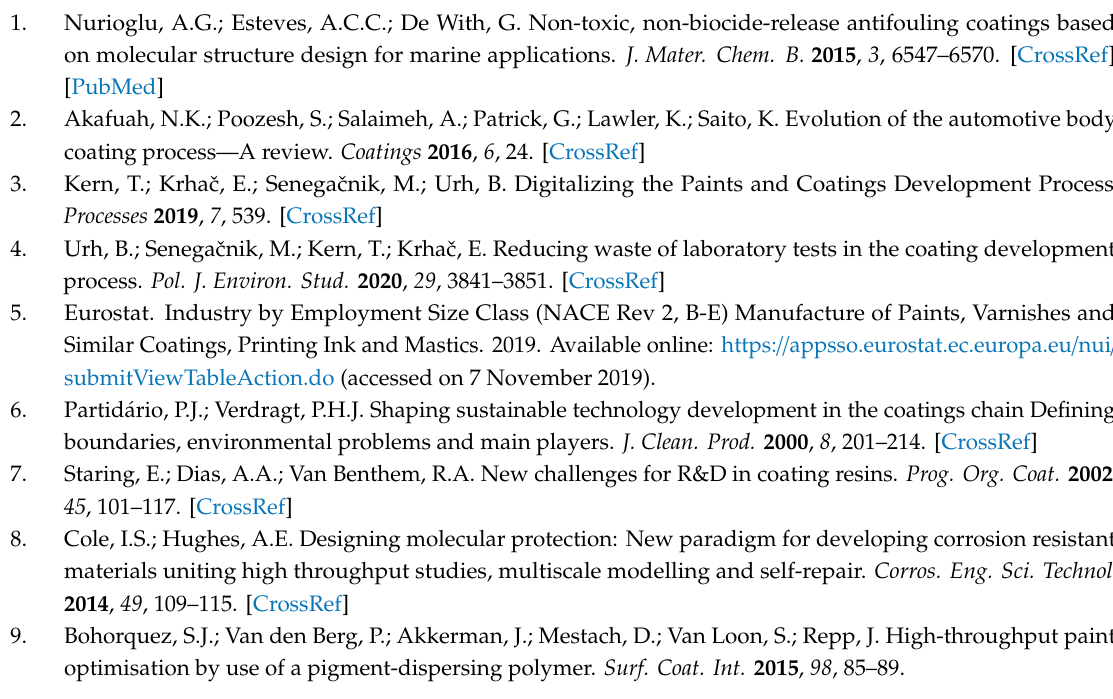
Figure 2. Example of the rentability threshold ’ s results in a calculator.